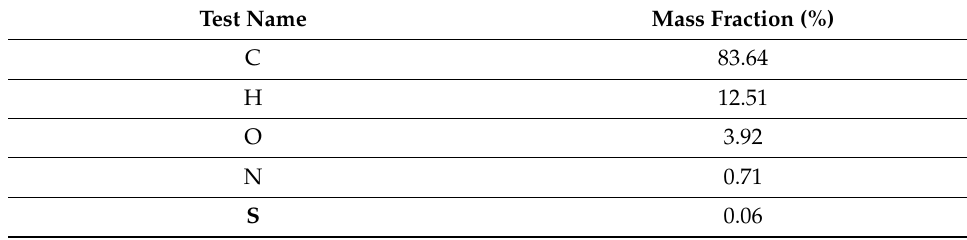
Table 2. Chemical element (C, H, O, N, S) analysis of crude